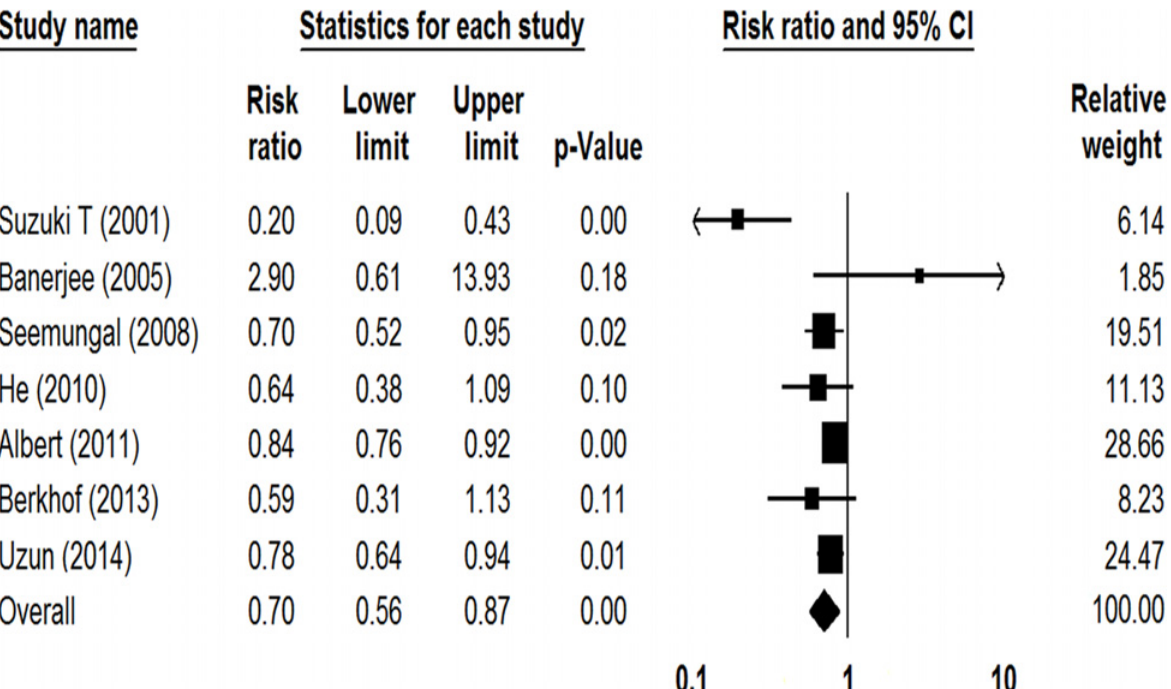
Fig 2. Forest plot of risk ratios for total number of patients with one or more exacerbations treated with macrolides compared with the control.